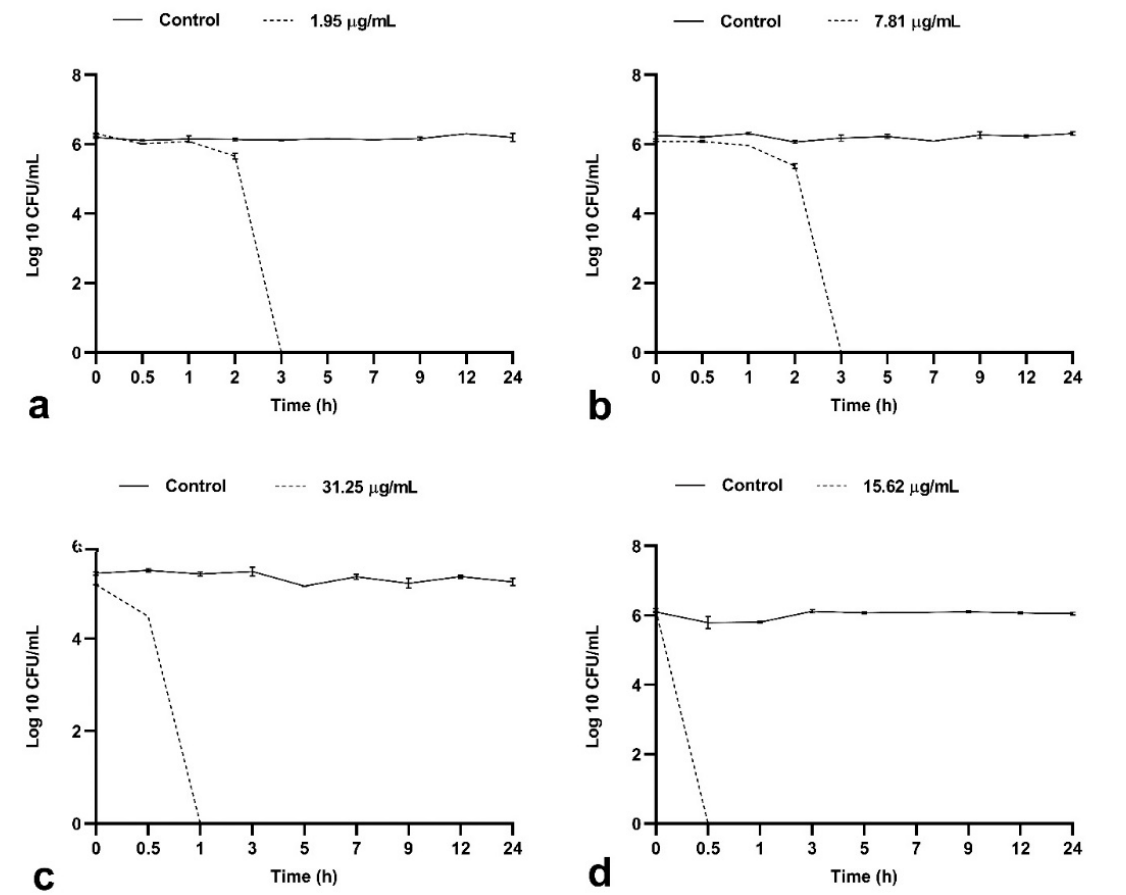
Figure 3. The time-killing kinetics of BrCl-flav against S. aureus medbio1-2012 ( a ), S. aureus prxbio1 ( b ), E. faecium medbio2-2012 ( c ) and A. baumannii medbio3-2013 ( d ). The bacterial cells were exposed to BrCl-flav at concentrations equivalent to MBC. Untreated cells served as control. The data were presented as the means of three independent experiments. Bars indicate SEM.